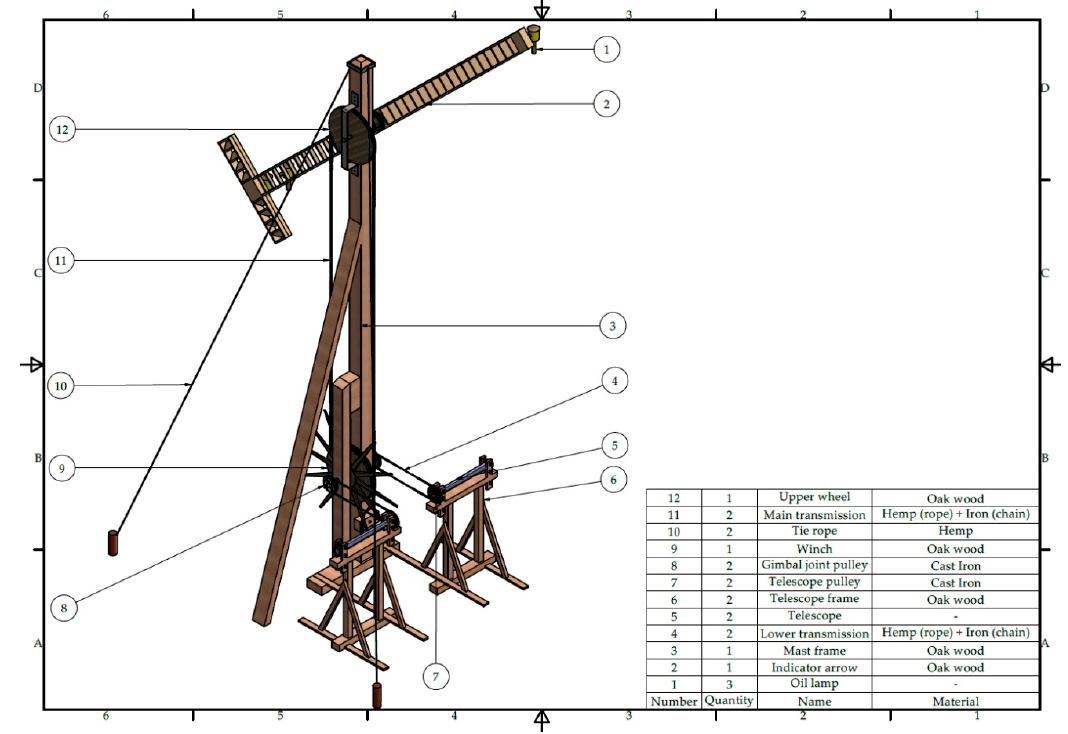
Figure 5. Plan of the ensemble of the optical telegraph with an indicative list of all its elements and materials.